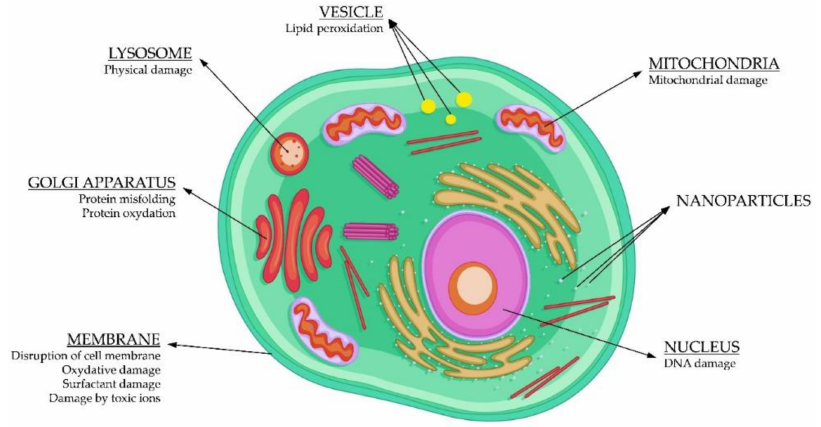
Figure 5. Toxic effects on the different intracellular objectives.